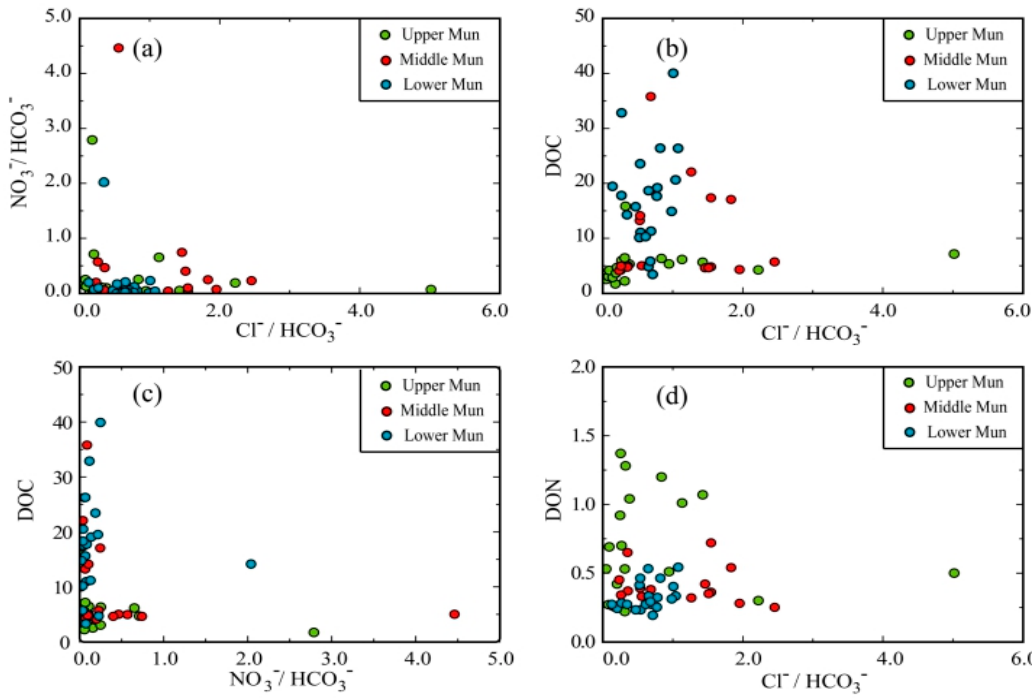
Figure 7. Correlations between the ions and DOC, DON: ( a ) Cl − /HCO 3 − vs. NO 3 − /HCO 3 − ; ( b ) Cl − /HCO 3 − vs. DOC; ( c ) NO 3 − /HCO 3 − vs. DOC; ( d ) Cl − /HCO 3 − vs. DON.